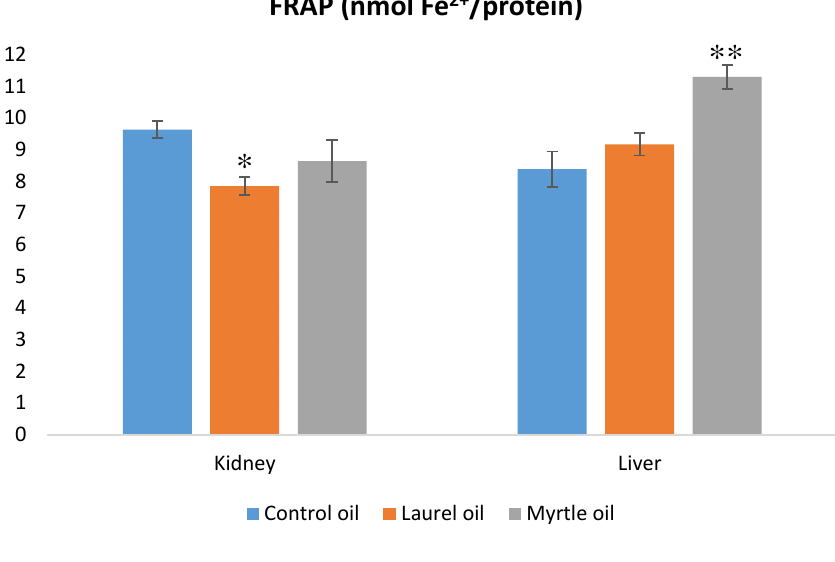
Figure 7. The effect of the laurel and myrtle EO application on the antioxidative capacity of the liver and kidney tissues homogenates measured by ABTS ( A ) and FRAP activity ( B ). Female rats ( n = 5) were administered ig with laurel and myrtle EOs at a dose of 1 μ L per 1 g of rats once daily for 14 days. Laurel and myrtle EOs were mixed with sunflower oil (1:1) and the total daily volume per rat was 0.5 mL. The control group was treated ig with 0.5 mL of sunflower oil. The results are expressed as the mean value of each experimental group ± SEM. * Significantly different in relation to the control group (* p < 0.05; ** p < 0.01). Abbreviations: ABTS, 2,2 ′ -azino-bis(3-ethylbenzothiazoline-6-